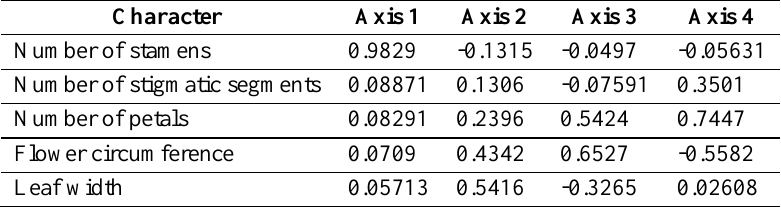
Table 2: PCA loadings of the highly contributed characters for the identification of the putative